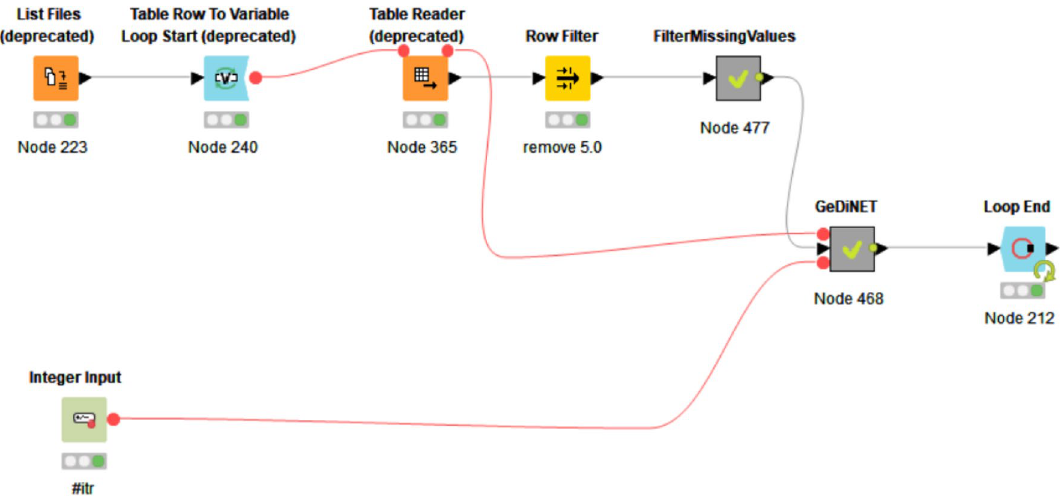
Figure 6. GediNET workflow in